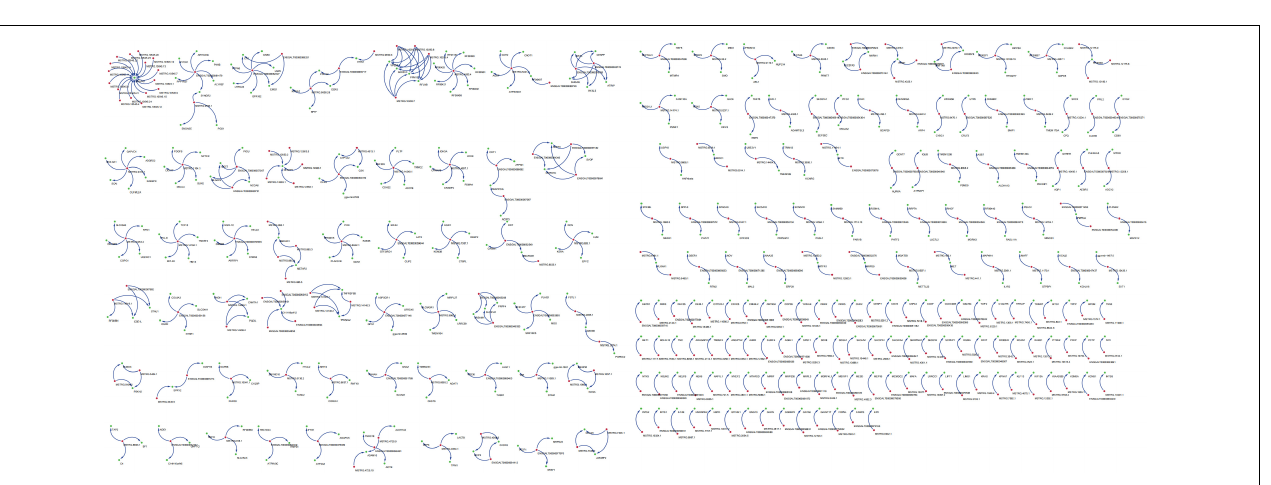
FIGURE 4 | Targeted regulatory relationships of lncRNA-mRNA. Green dots represent differentially expressed genes and blue dots represent differentially expressed